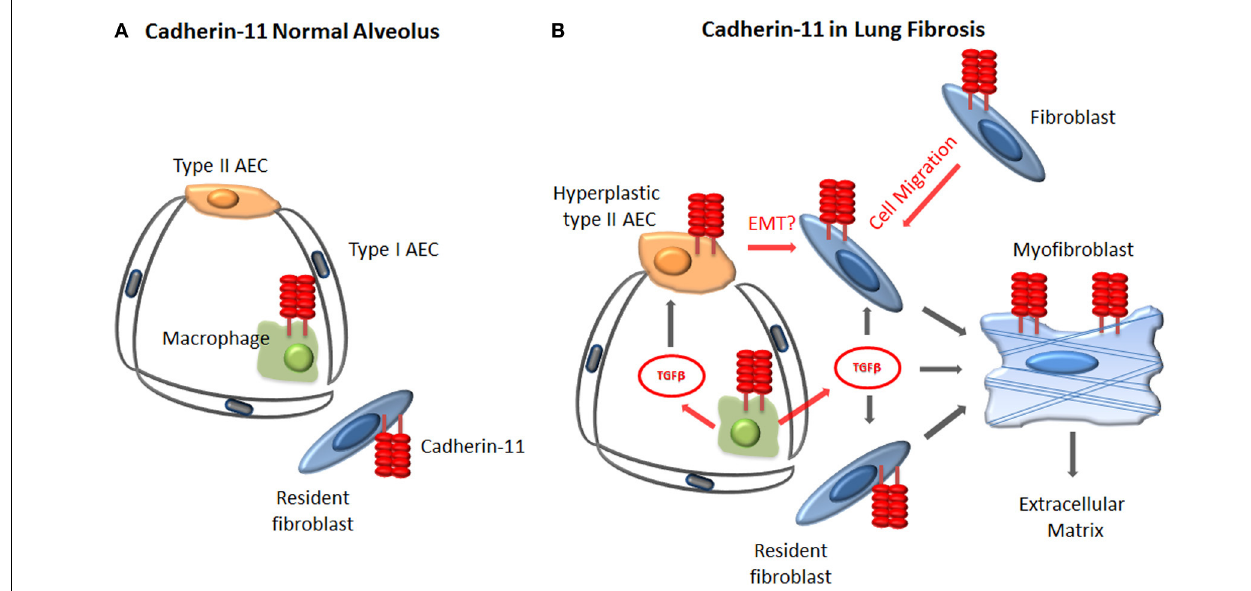
FIGURE 2 | Proposed cellular mechanisms by which cadherin-11 regulates fibrosis. (A) In the healthy lung, cadherin-11 is expressed on the resident fibroblasts and at low levels on the alveolar macrophages. (B) During fibrosis cadherin-11 expression is noted on fibroblasts, myofibroblasts,